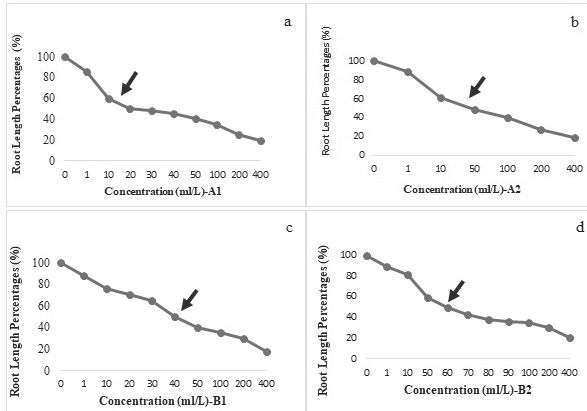
Figure 1. EC50 values determined for the four different detergents, a. detergent A1, b. detergent A2, c. detergent B1, d. detergent B2. Arrows show the EC50 values.